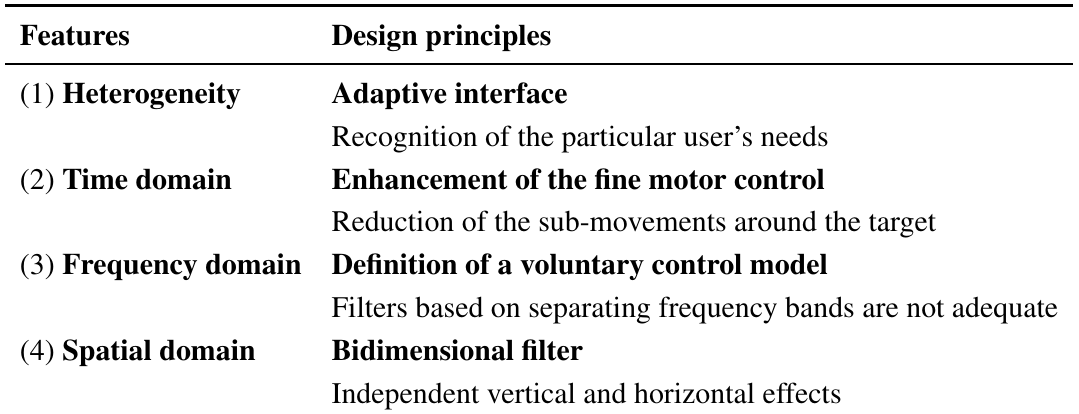
Table 4. Design principles of the filtering technique based on characterization.